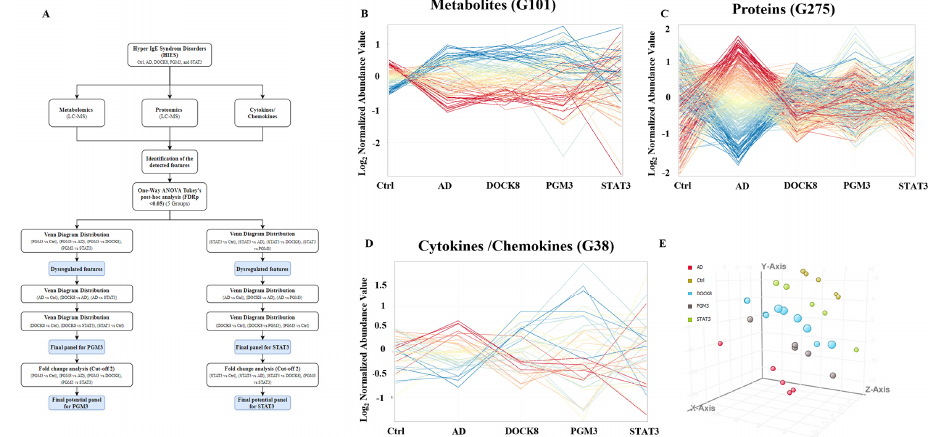
Figure 1. Multi-omics profiles in five study groups and the data analysis pipeline: ( A ) A flow chart showing the data analysis pipeline collected from metabolomics, proteomics, and cytokines platforms. The significant features in each dataset were determined for PGM3 and STAT3 deficiencies, based on One-way ANOVA. Those in common with the other disorders (AD and DOCK) were then excluded using Venn diagram analysis. The final list features were fold change filtered (Cut-off > 2). The expression profile of ( B ) metabolomics ( n = 101), ( C ) proteomics ( n = 275), and ( D ) cytokines ( n = 38) in the five groups. ( E ) A PLS-DA shows a clear separation between the study groups due to the proteomics differential expression.